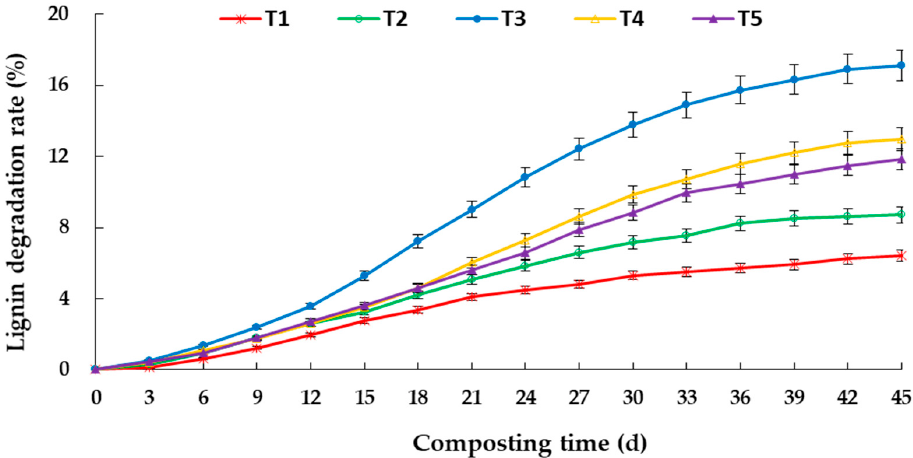
Figure 5. Changes in lignin degradation rate during composting of corn straw and cow dung under different C/N